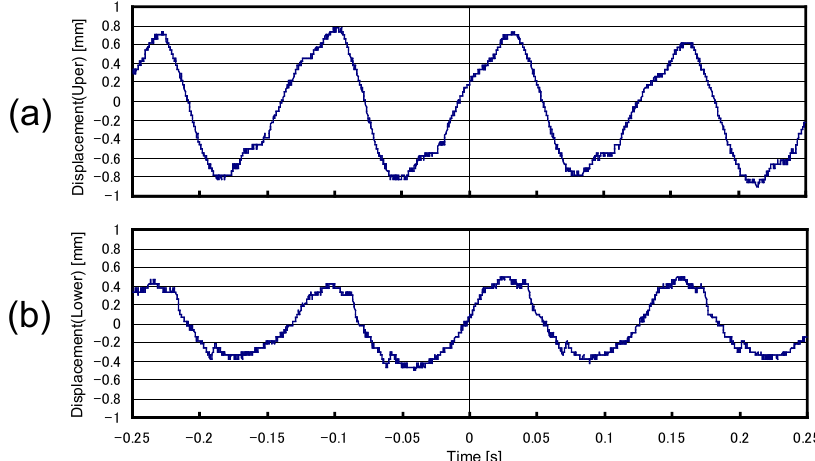
Figure 17. Free-run experimental result showing ( a ) displacements at upper position of rotor and ( b ) displacements at lower position of rotor at a speed of ≈ 370